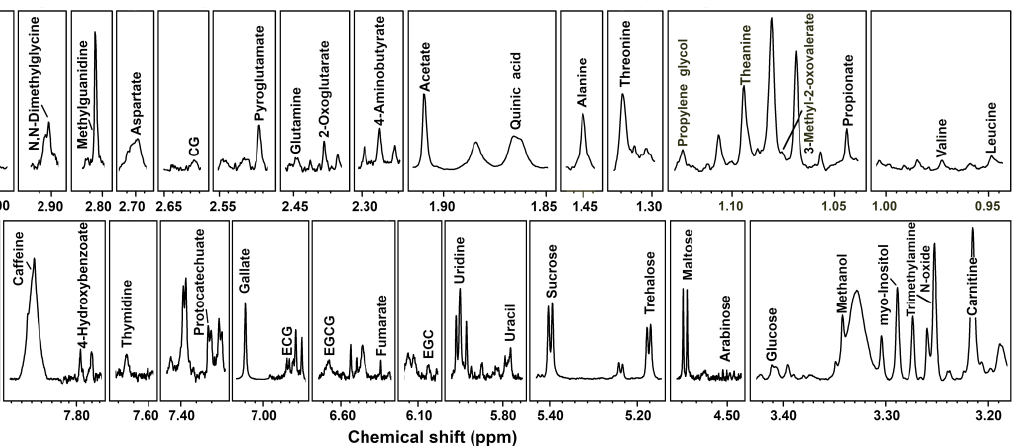
Figure 1. Portions of 1 H-NMR spectra from typical Ya’an Tibetan tea samples. Name of the molecules appears on the signals used for their quantification. The vertical scale of each portion is conveniently set to ease the signals observation.